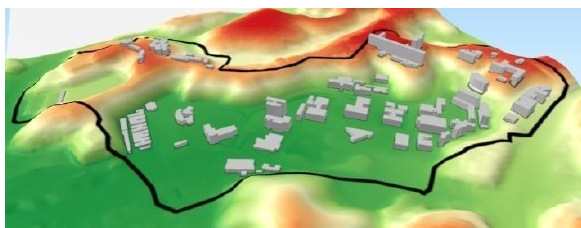
Figure 9: The result of the geometric modeling from the DTM and the planimetric survey of the campus